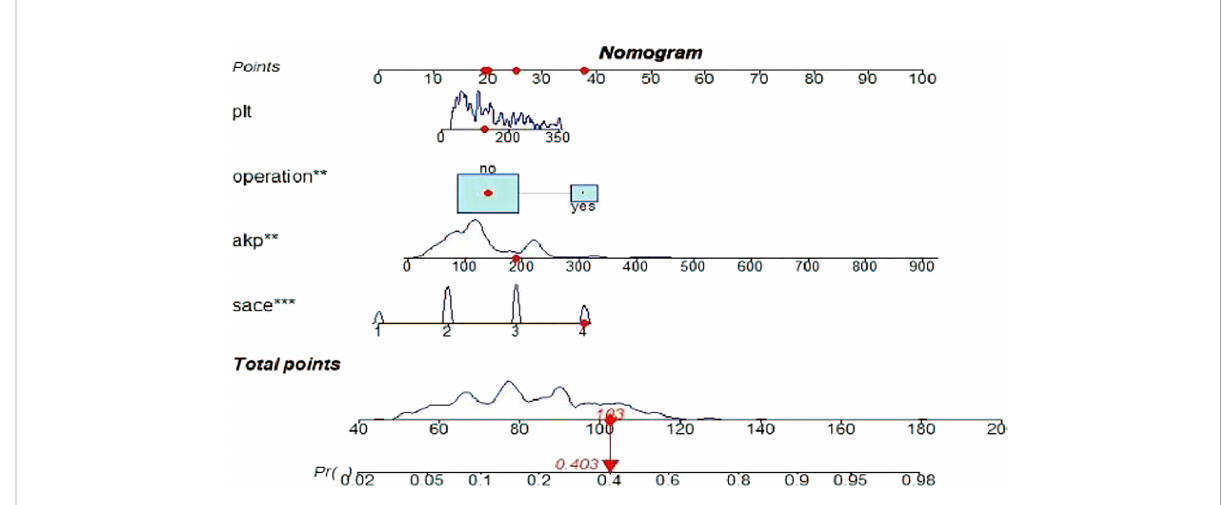
FIGURE 4 Risk nomogram model for the prediction of bile duct injuries after DEB-TACE in patients with HCC. **, *** refers to the contribution